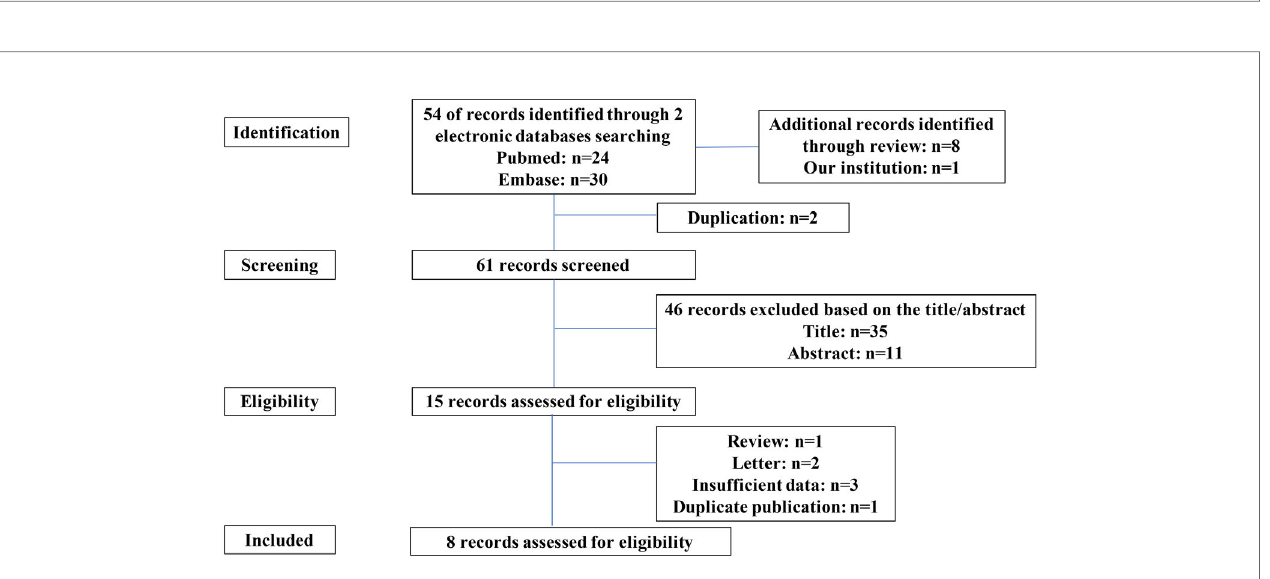
FIGURE 3 | Literature search and study selection procedures.